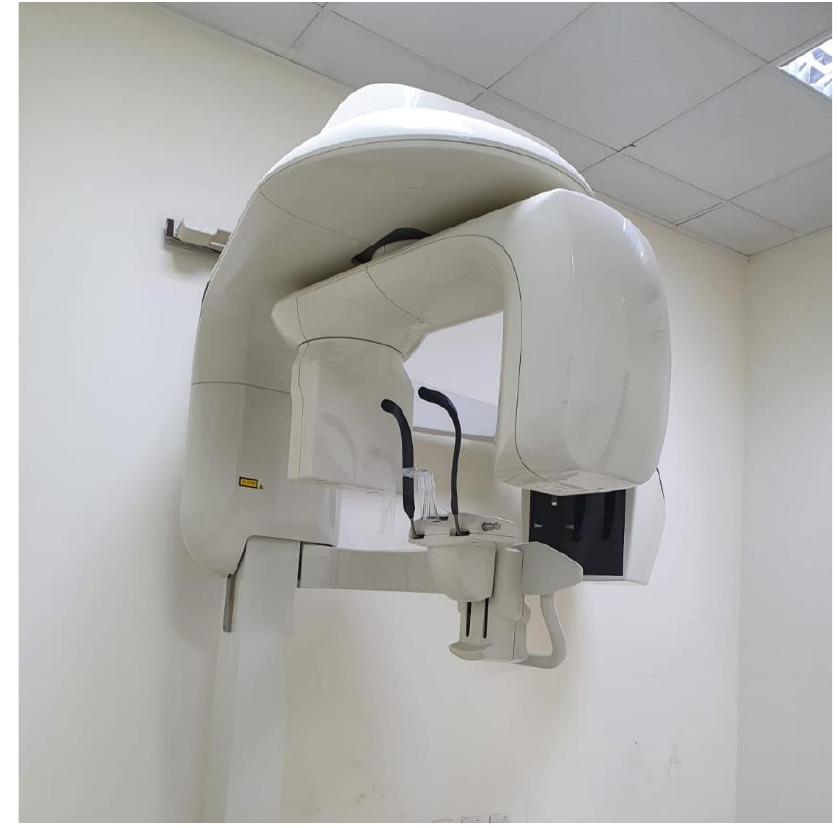
Figure 2. CBCT machine.